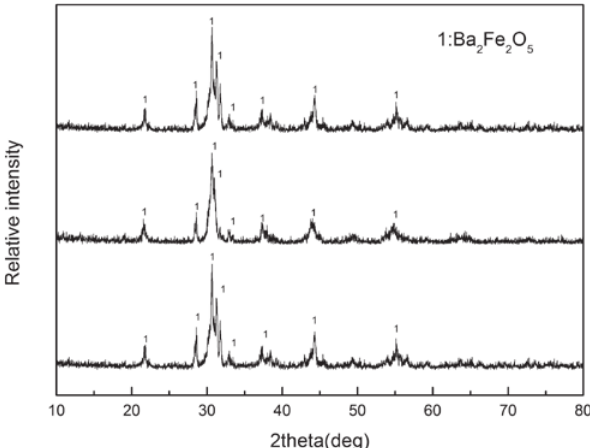
Fig. 1: Schematic diagram of the apparatus.